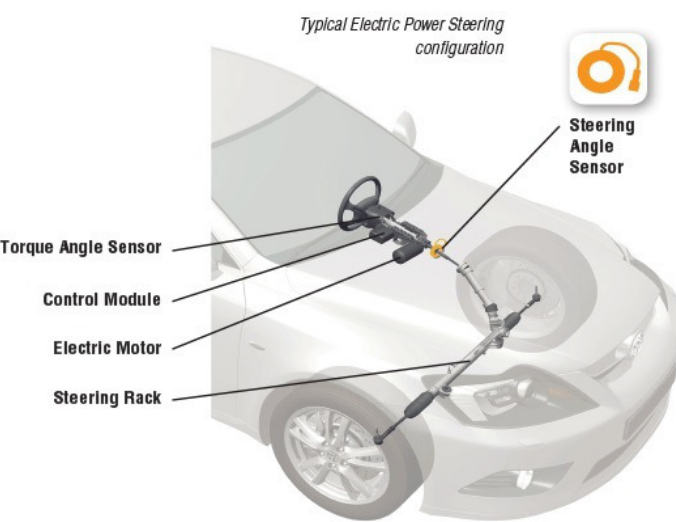
Figure 14. Steering system of a typical modern era vehicle [34].